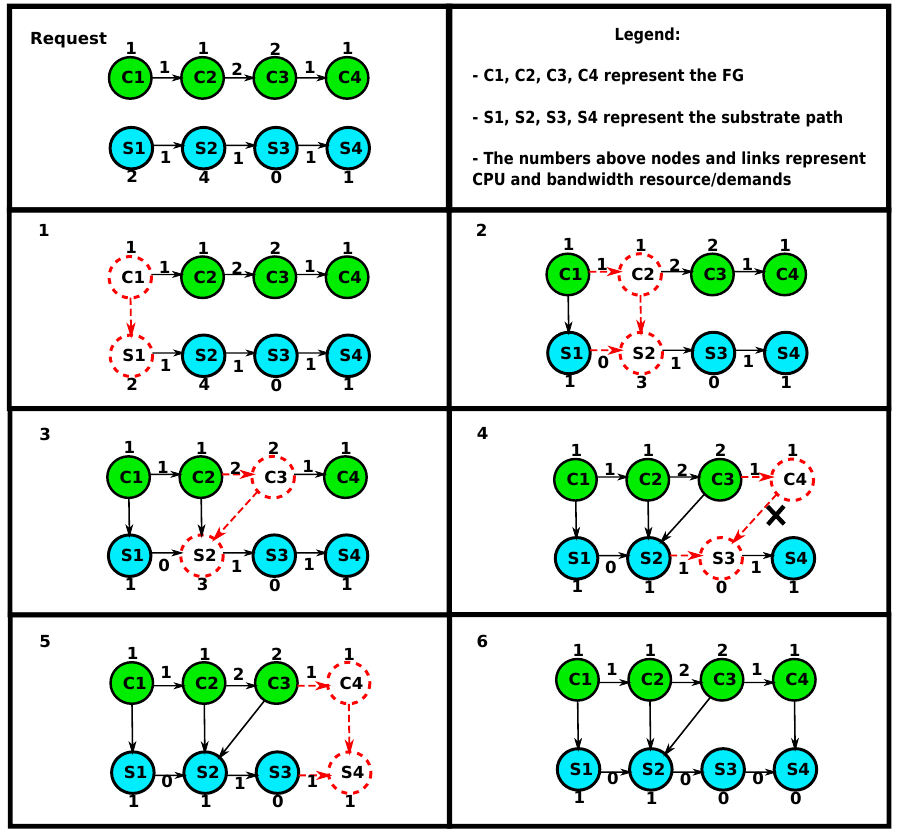
Figure 5. Proactive FG embedding